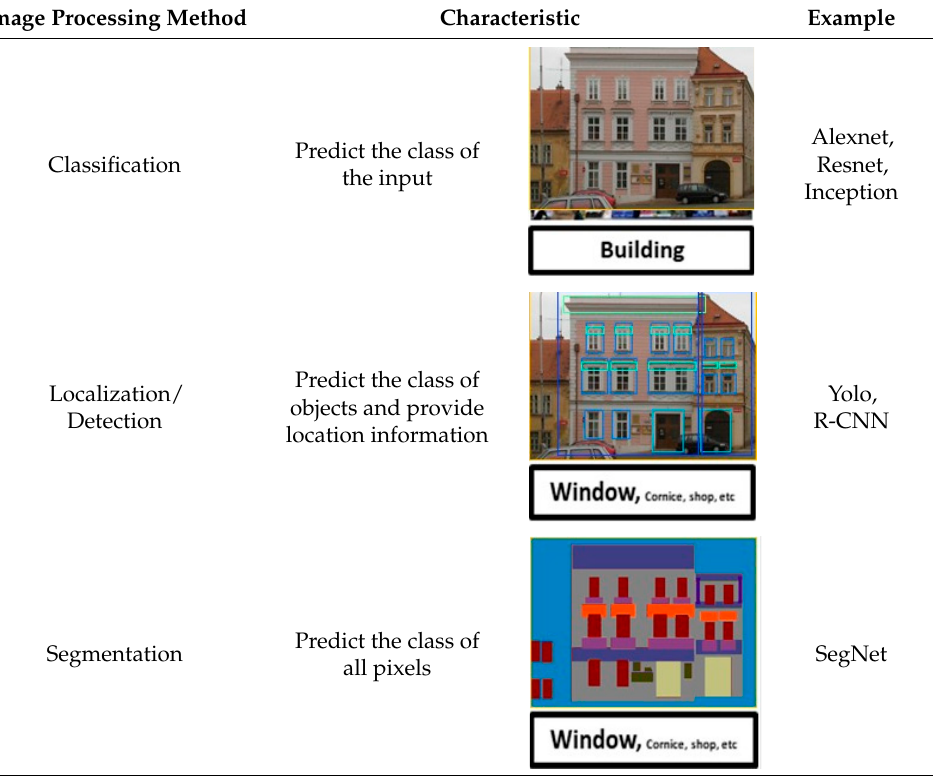
Table 2. Research related to façade segmentation.